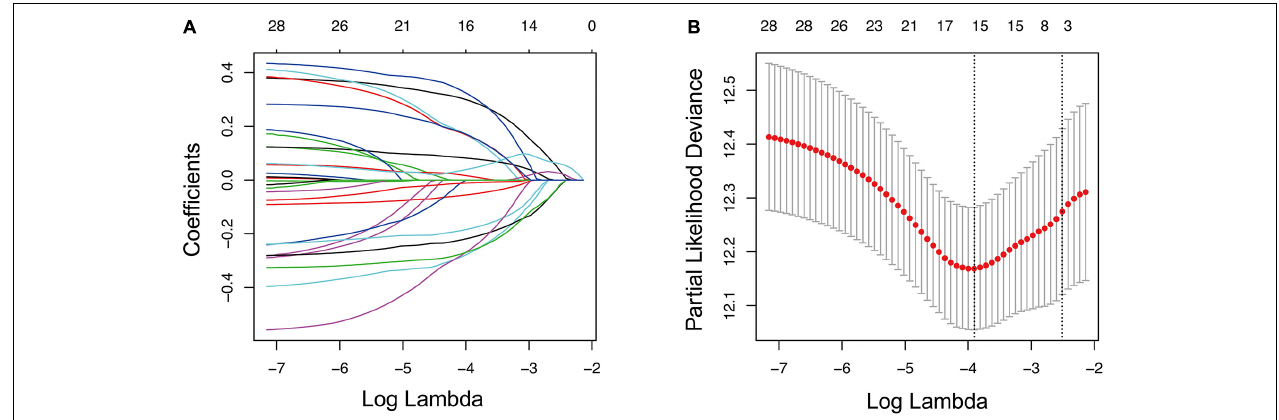
FIGURE 2 | Construction of prognostic gene signature using LASSO regression analysis. (A) LASSO coefficient profiles of 29 ferroptosis-related potential prognostic genes. Each curve corresponds to a gene. (B) Selection of the optimal parameter in LASSO regression with 10-fold cross-validation. LASSO, the least absolute shrinkage and selection operator Cox regression